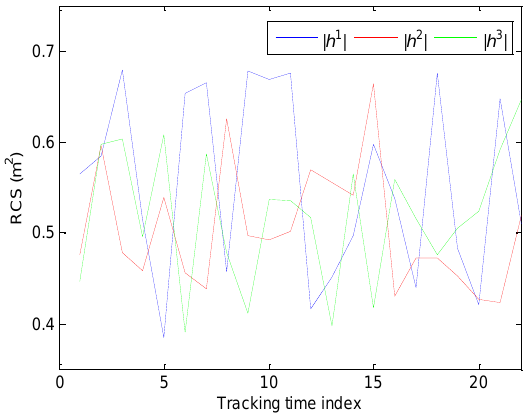
Figure 4. The radar cross section ( RCS) of the target relative to different radars.